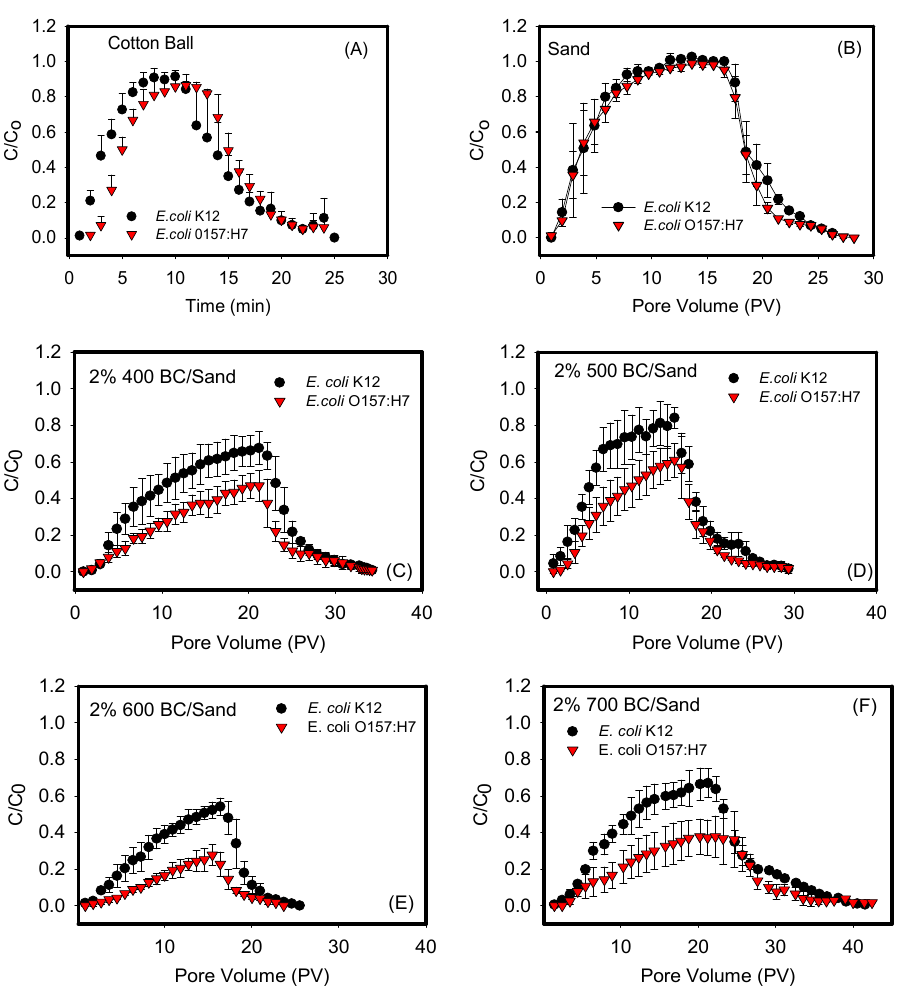
Figure 1. Breakthrough curves (BTCs) for negative controls: ( A ) cotton ball, ( B ) sand, and ( C – F ) biochars 400, 500, 600, and 700 °C. Each curve represents a triplicate with error bars representing the standard deviation. Data shown in ( A – C ) quantified between cotton, sand, and biochar 400 and each of the two bacterial strains were statistically similar with p values of 0.984, 0.268 and 0.061, respectively. Data shown in ( D – F ) quantified between biochars 500, 600, and 700 ◦ C and each of the two bacterial strains were statistically different with p values of 0.038, 0.017, and 0.024,